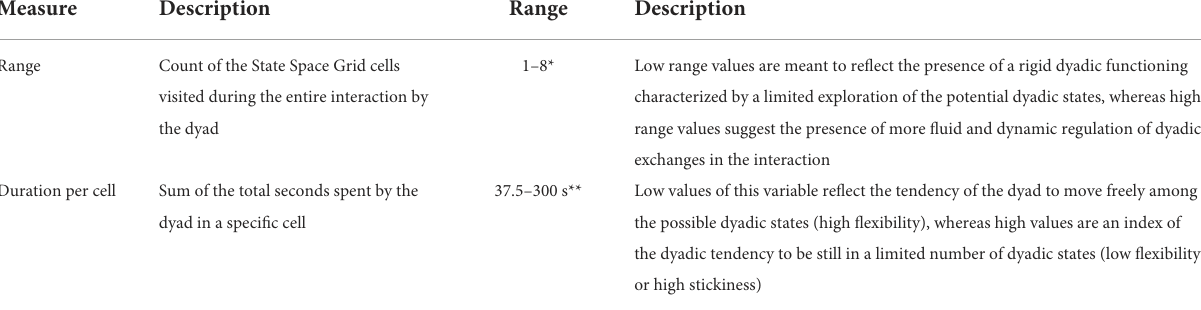
TABLE 2 Content-free dyadic measures.